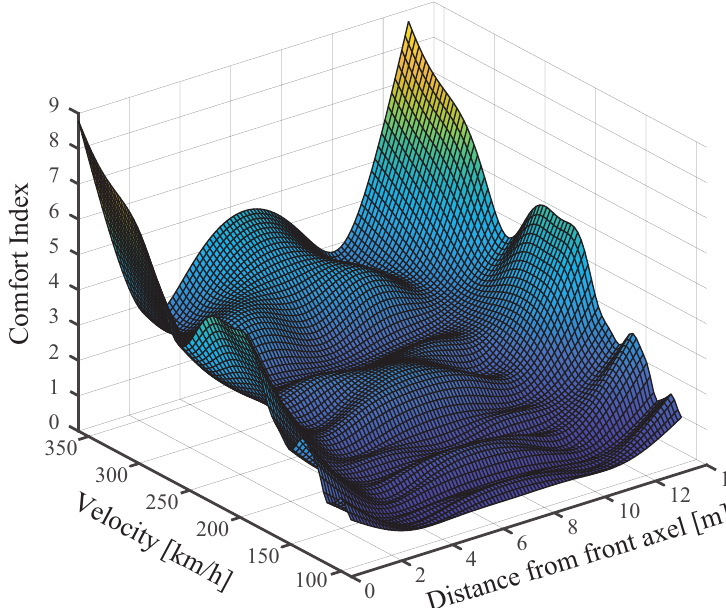
Figure 13. Comfort index along the length of the beam versus speed ( v ).